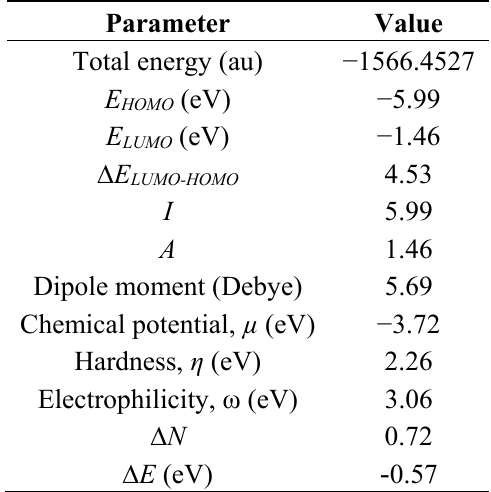
Table 5. Some gas-phase quantum chemical parameters of SB calculated at B3LYP/6-31G(d)